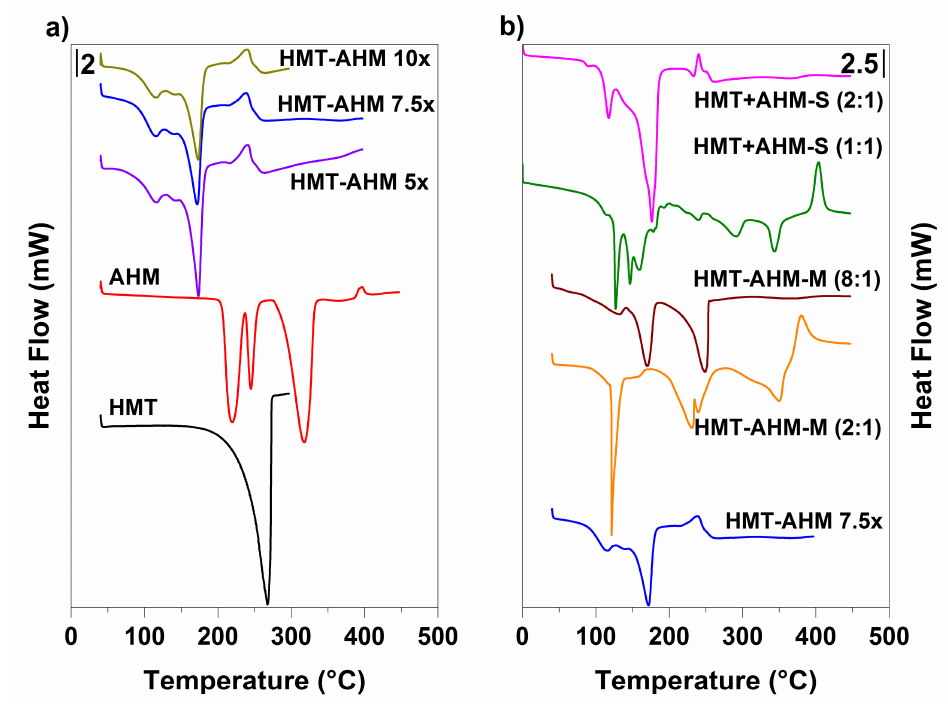
Figure 4. Thermal behavior of the synthesised precursors ( a ) and the starting feedstock ( b ) provided by differential scanning calorimetry